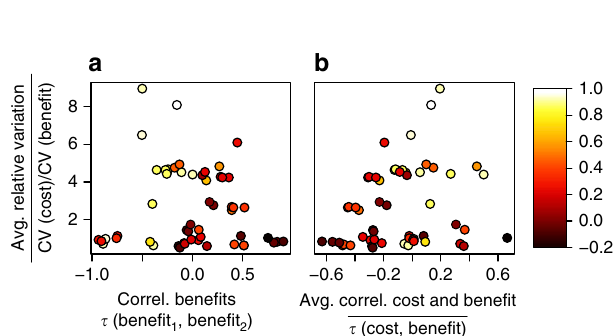
Fig. 3 Case study results showing the change in agreement levels when moving to ROI methods. Case study results showing change in agreement levels when moving to ROI-based prioritization (ROI Agreement − Bene fi t Agreement) for 55 pairs of bene fi t metrics. Change in agreement levels is shown as a function of ( a , horizontal axis) the correlation between the two bene fi t metrics, ( b , horizontal axis) the correlation between each bene fi t metric and cost, and ( a and b , vertical axes) the relative variation in bene fi t and cost, where the latter two measures are averaged across the two bene fi t functions and Kendall ’ s τ is used to assess correlations. Each point corresponds to a pair of bene fi t metrics. Lighter shading corresponds to larger improvements in agreement